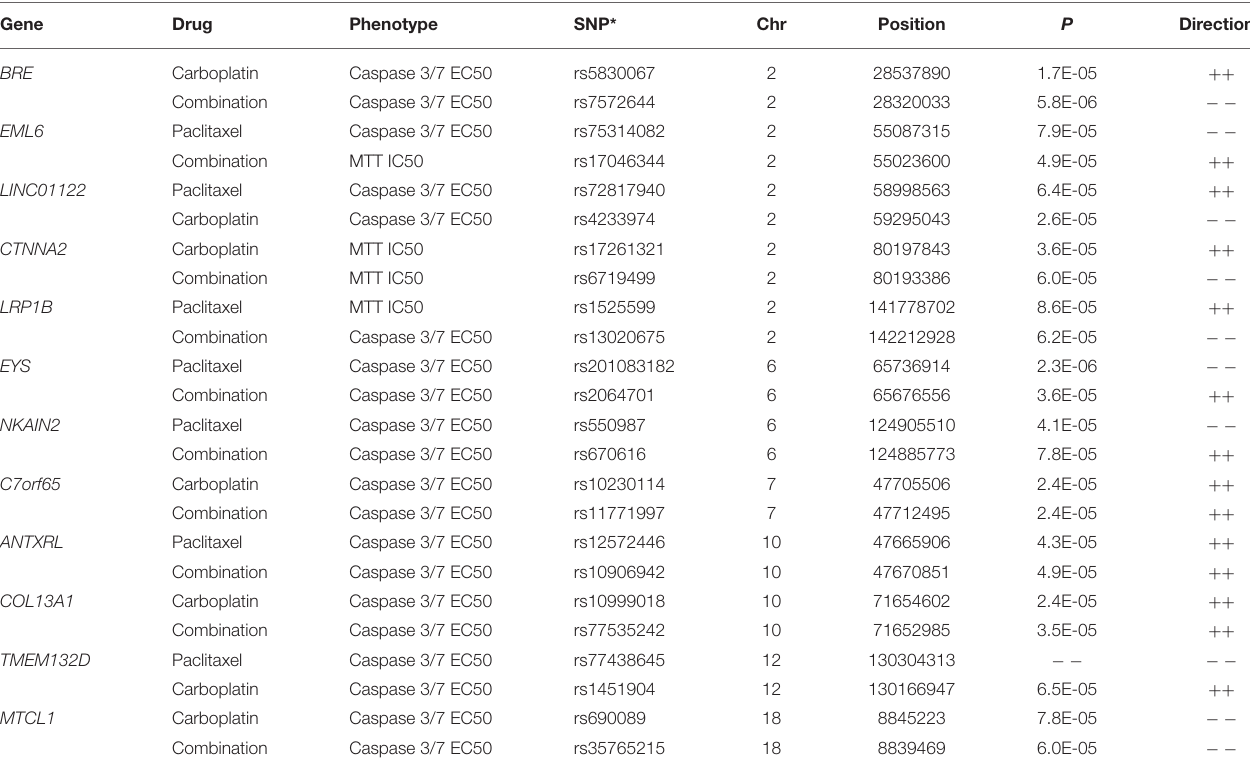
TABLE 3 | Gene regions with SNPs associated with multiple drugs for any phenotype ( p < 0.0001).